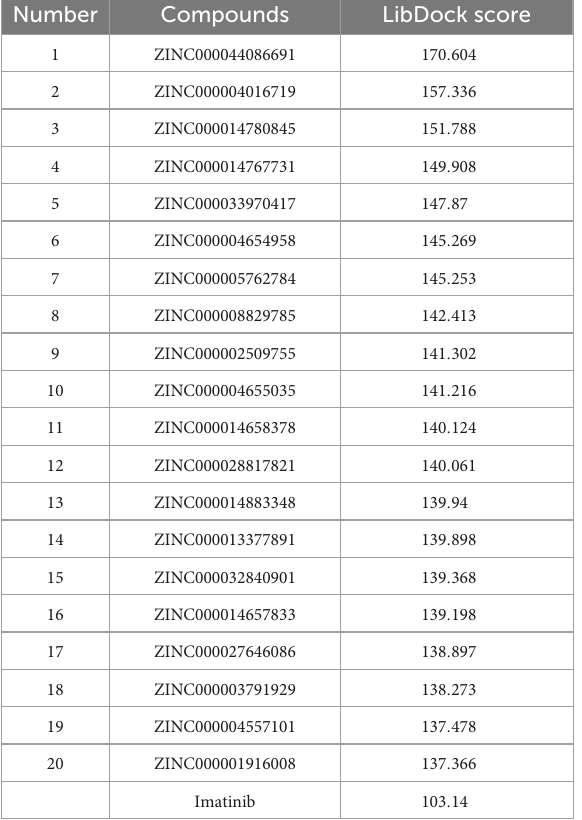
TABLE 1 Top 20 ranked compounds with LibDock